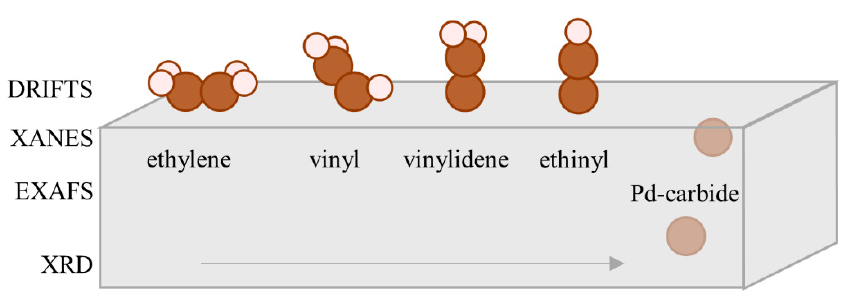
Figure 6. Ethylene dehydrogenation pathway based on XRD, EXAFS, XANES and DRIFTS data.